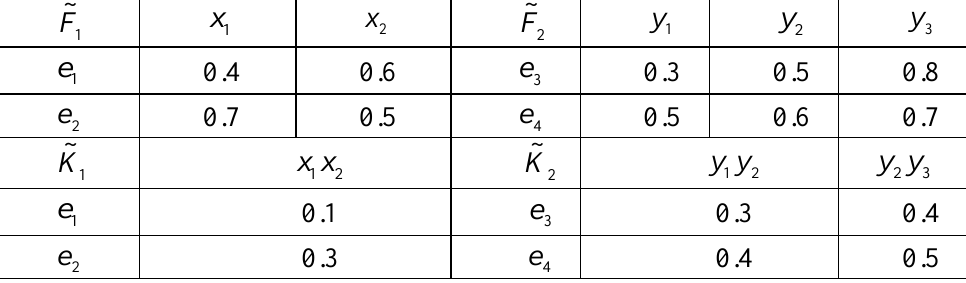
Table 1 : Tabular representation of two fuzzy soft